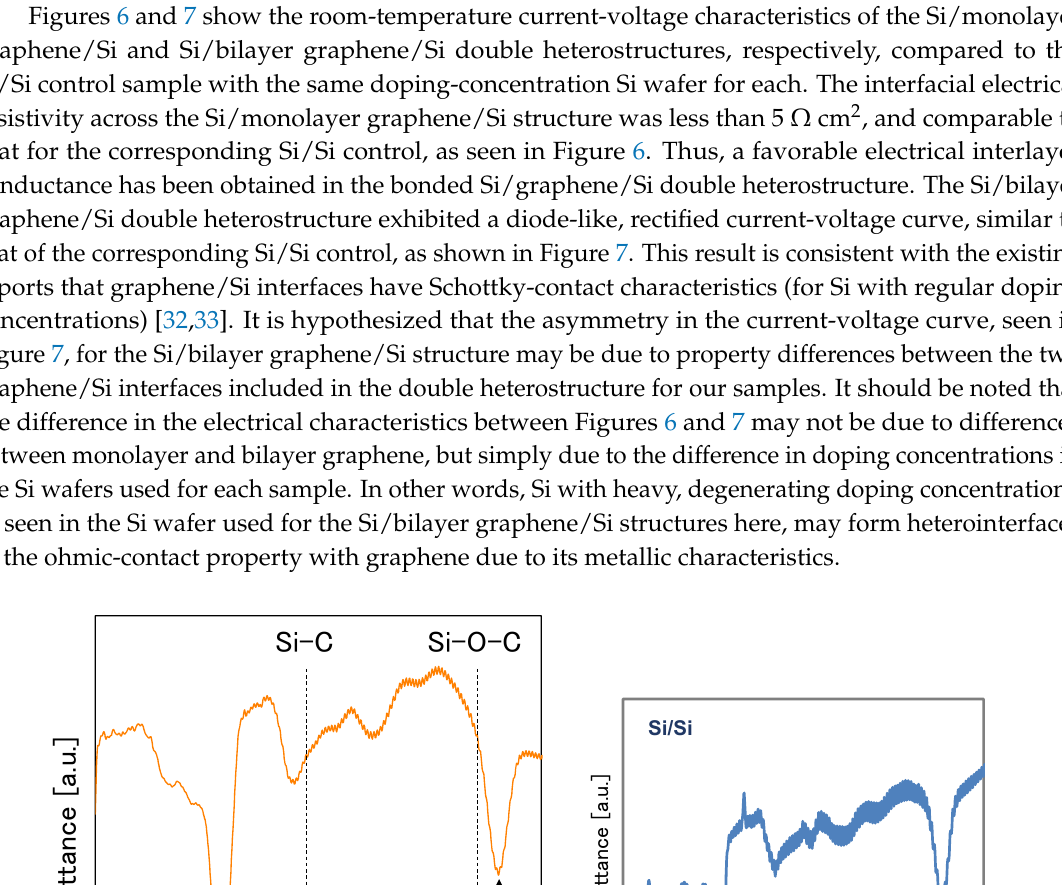
Figure 5. Conceptual schematic of a cross-sectional molecular view of the bonded interfaces: ( left ) Si/Si control structure, ( right ) Si/graphene/Si double heterostructure.